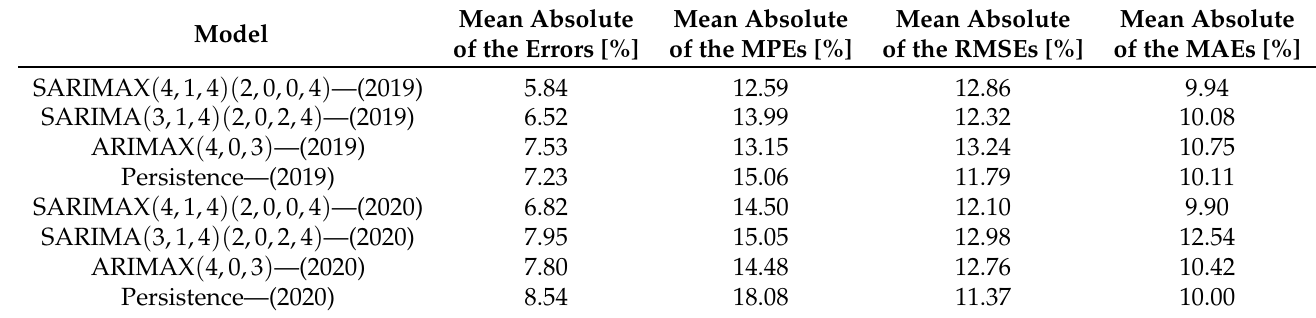
Table 9. Comparison between ARIMA-based and persistence models for a 30-day period between late spring and early summer in 2019. The reported results for 2019 can be used to demonstrate the suitability of the same model to forecast the same period in